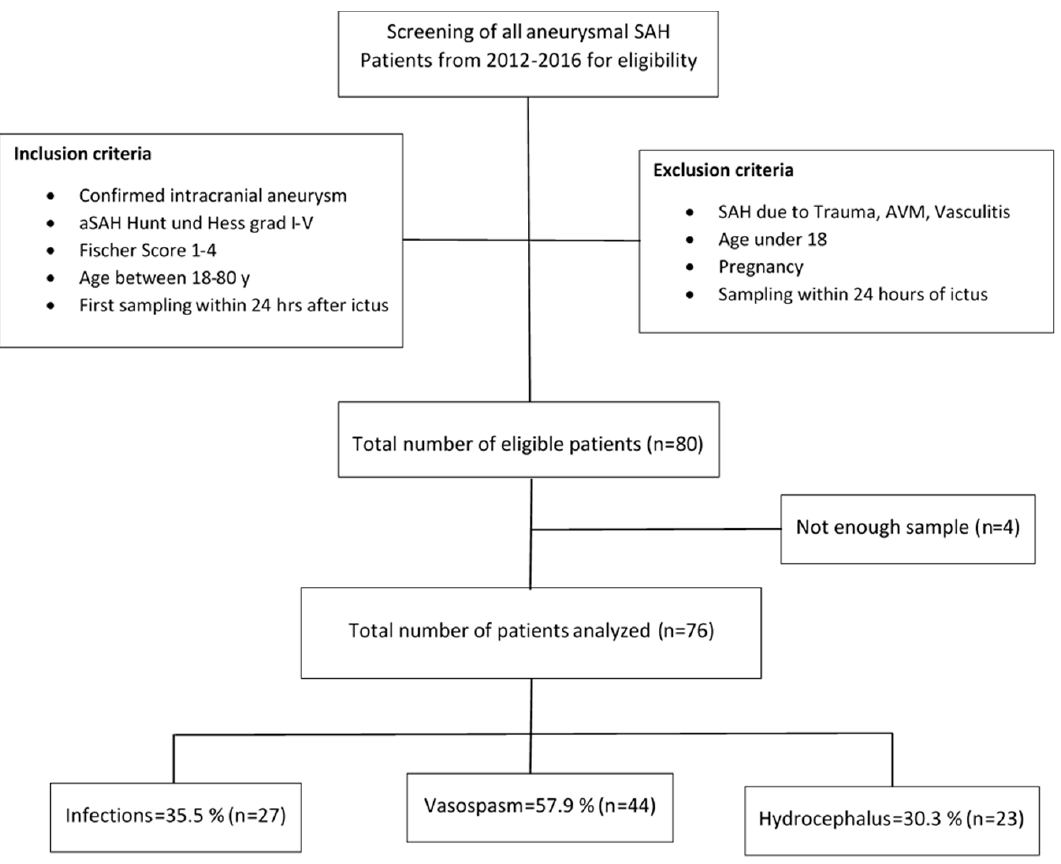
Figure 1. Flow diagram representing the final number of SAH patients and control patients for serum Interleukin (IL)-10 analysis.